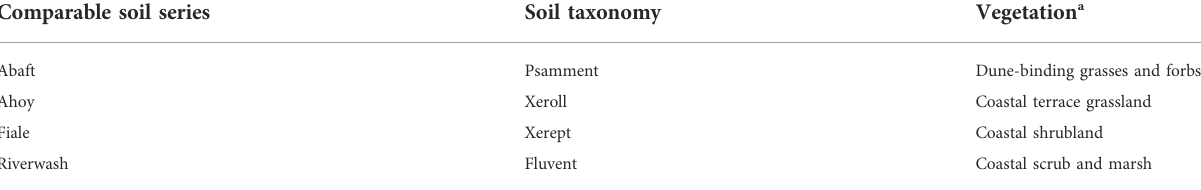
TABLE 3 Soil series recognized from paleosols in cores between Santa Cruz and Santa Rosa